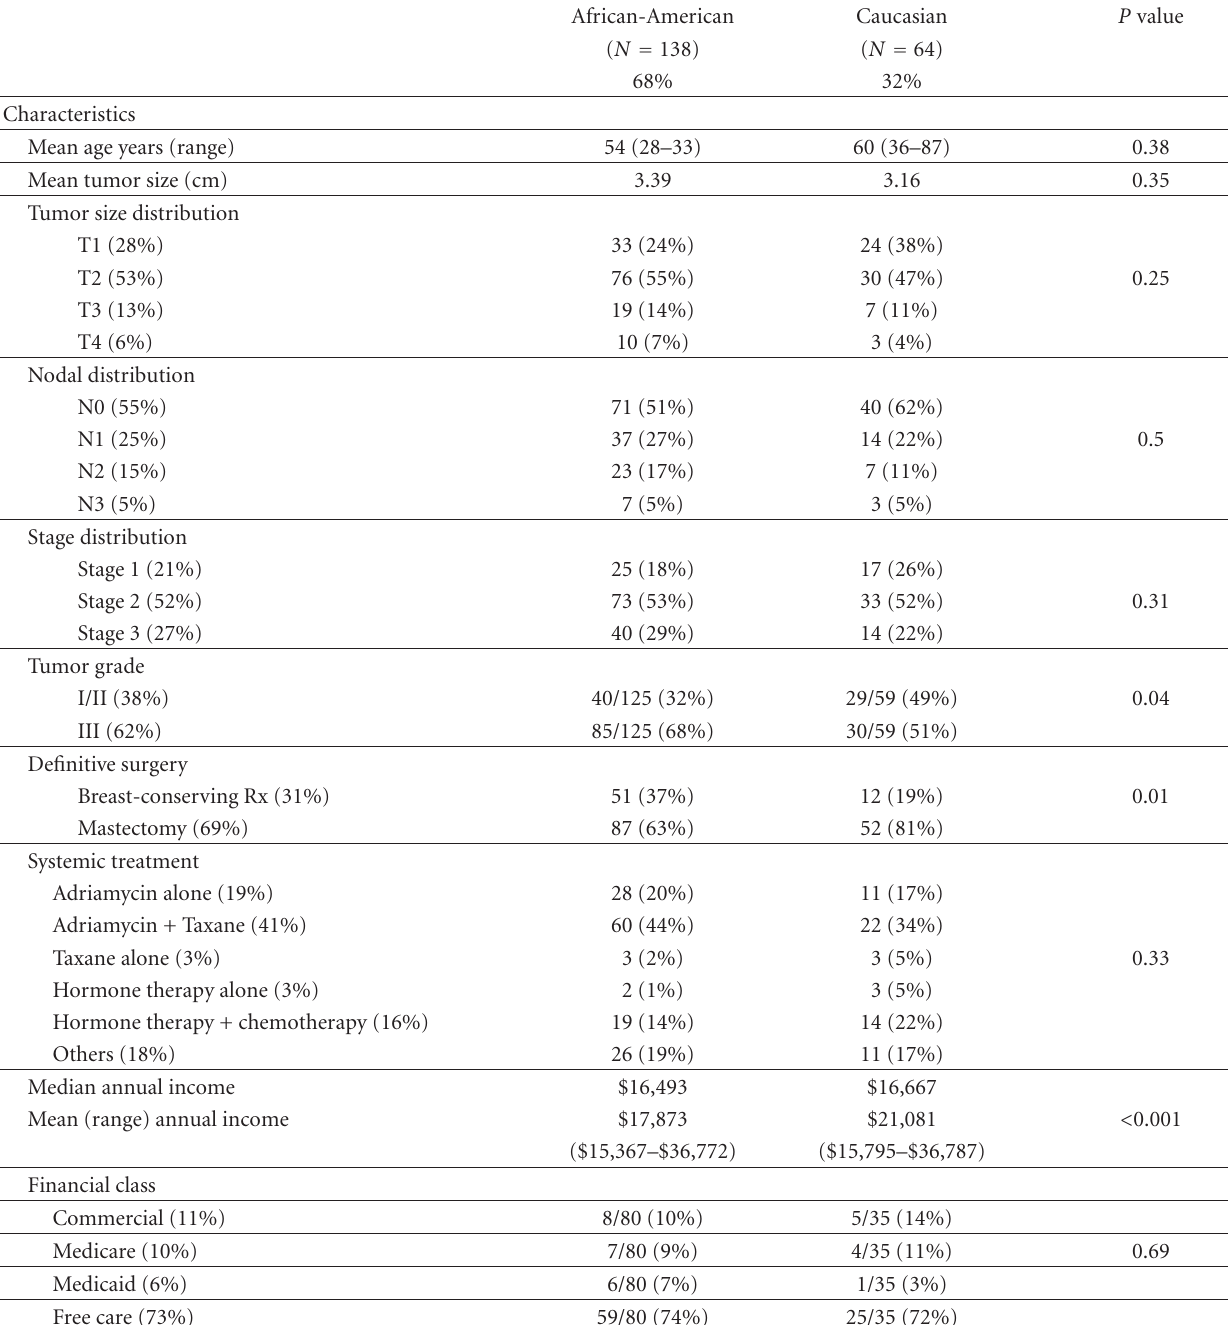
Table 1: Distribution of patient, clinicopathologic, and socioeconomic characteristics of 202 Patients with triple negative breast